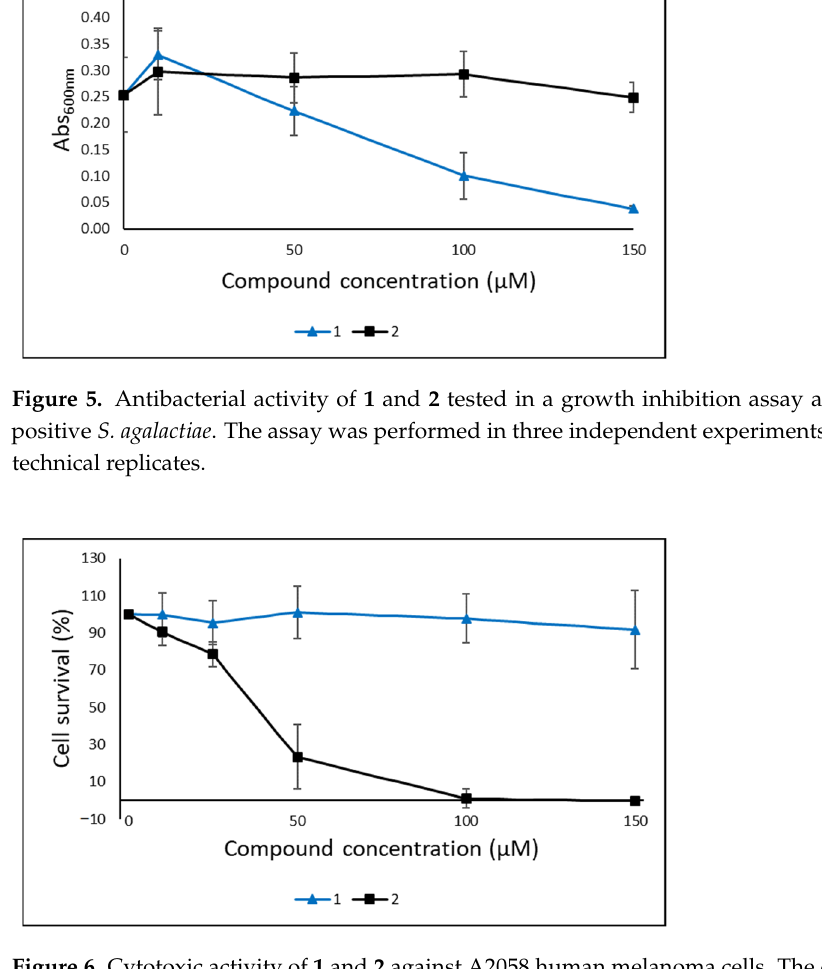
Figure 5. Antibacterial activity of 1 and 2 tested in a growth inhibition assay against the Gram- positive S. agalactiae . The assay was performed in three independent experiments, each with three technical replicates.